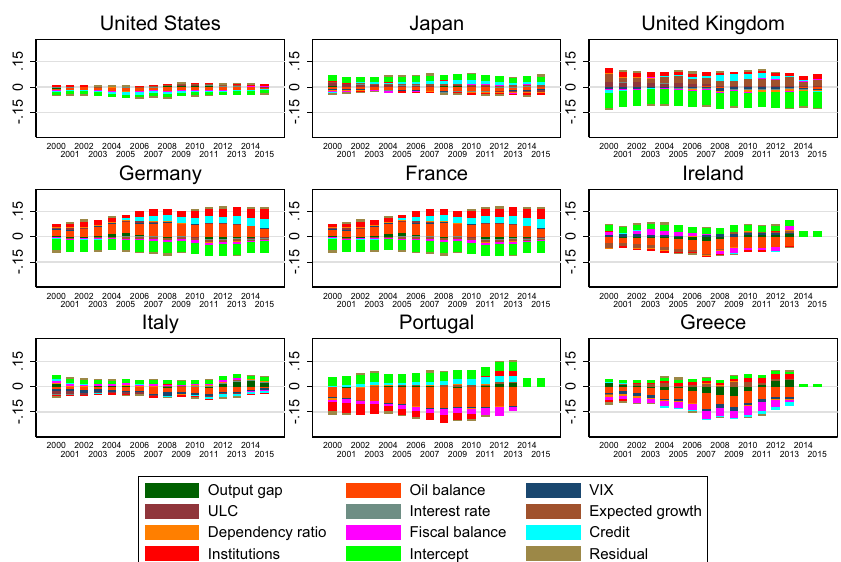
Fig.13 Detailed current account decomposition for selected countries. Notes. This figure plots the detailed decomposition with the contribution of each of the regressors included in the analysis (oil balance also includes oil prices) for a sample of